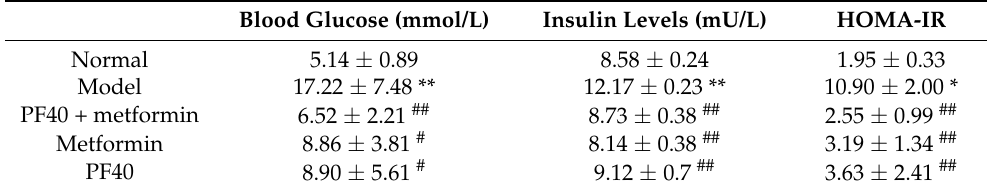
Table 1. Effect of PF40 on fasting blood glucose, insulin levels, and HOMA-IR in T2DM rats ( n = 9). Blood Glucose